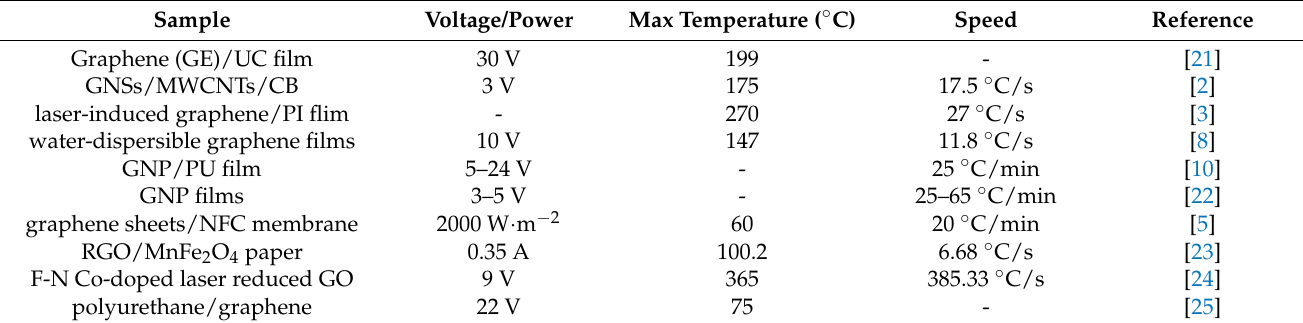
Figure 7. Heating curves of TiO 2 /GNs and GNs films. Table 3. Summary of other electrothermal films.